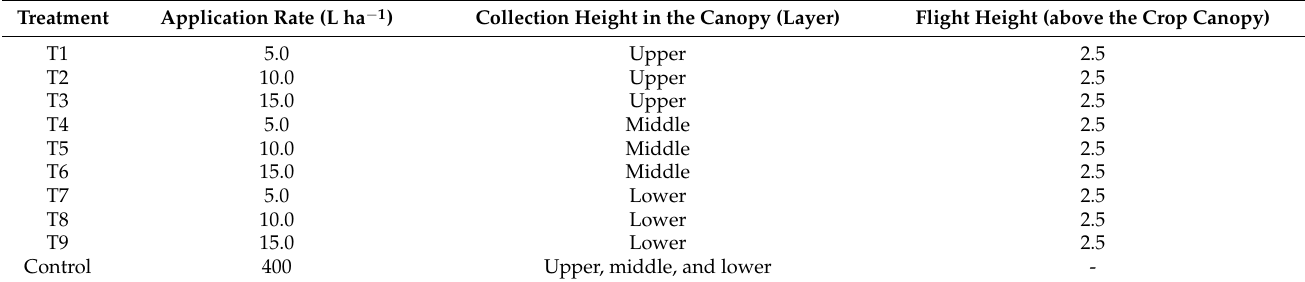
Figure 2. Pneumatic sprayer used for application in the control treatment. Table 2. Experimental treatments for analysis of application quality variables.